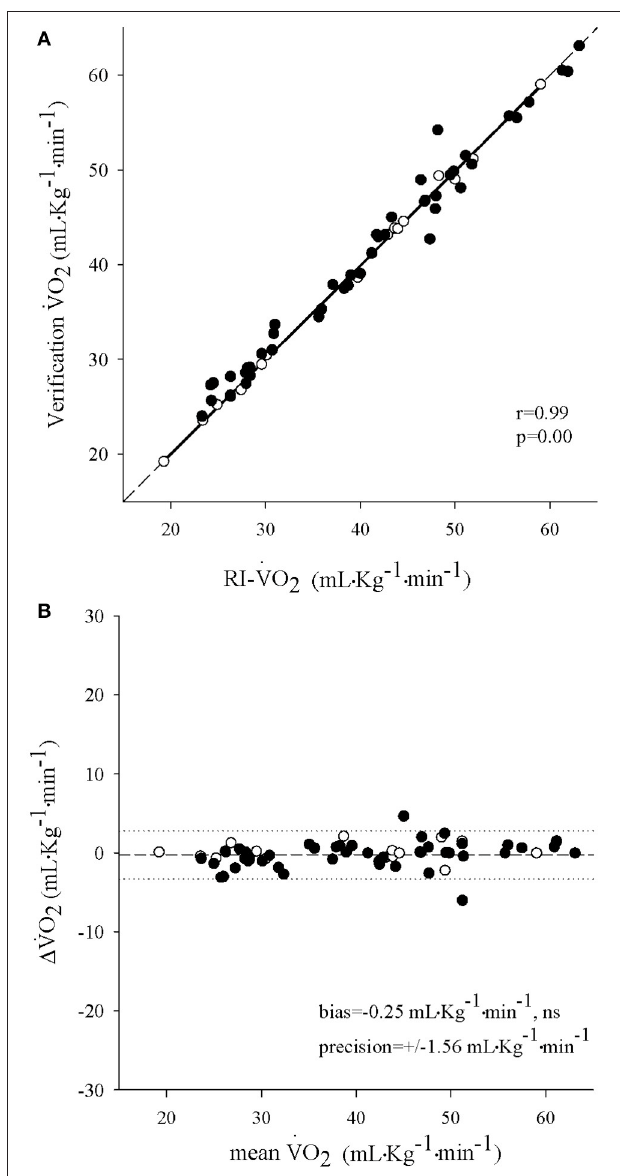
FIGURE 1 | (A) The highest individual ˙VO 2 values observed during the verification phase (verification-˙VO 2 ) are correlated with the values measured during the ramp incremental test (RI-˙VO 2 ). The identity (dashed) and the correlation (solid) lines are displayed along with the correlation coefficient for the entire database. Data of subjects who completed the verification phase at 105 and 85% of maximal power output are displayed as filled (•) and empty circles ( ◦ ) respectively. (B) Individual absolute differences ( 1 ˙VO 2 ) between measures of the highest ˙VO 2 during the RI test and the verification phase are plotted as a function of the average of the two measures. Bias (dashed line) and precision (limits of agreement, dotted lines), for the entire database, are displayed along with the numerical values. Data of subjects who completed the verification phase at 105 and 85% of maximal power output are displayed as filled (•) and empty circles ( ◦ )